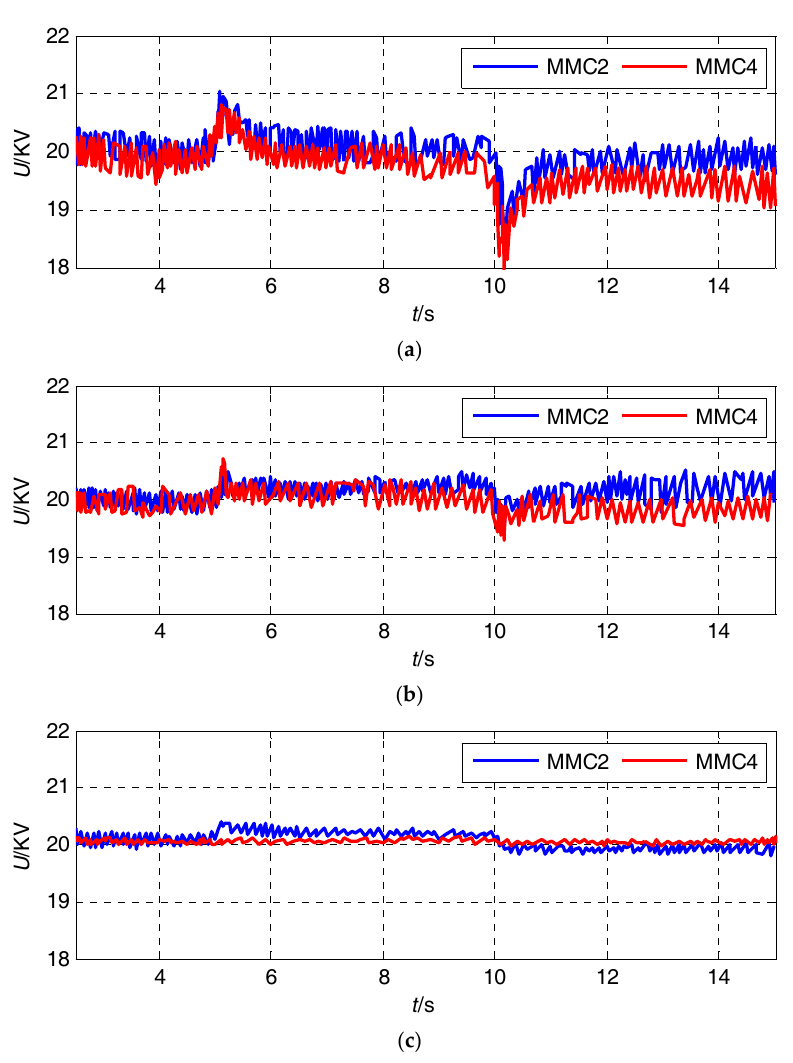
Figure 9. Simulation waveforms of load fluctuation: ( a ) The DC voltage controlled by DCLC; ( b ) the DC voltage controlled by FCS ‐ MPC; ( c ) the DC voltage controlled by the HM 2 PC.